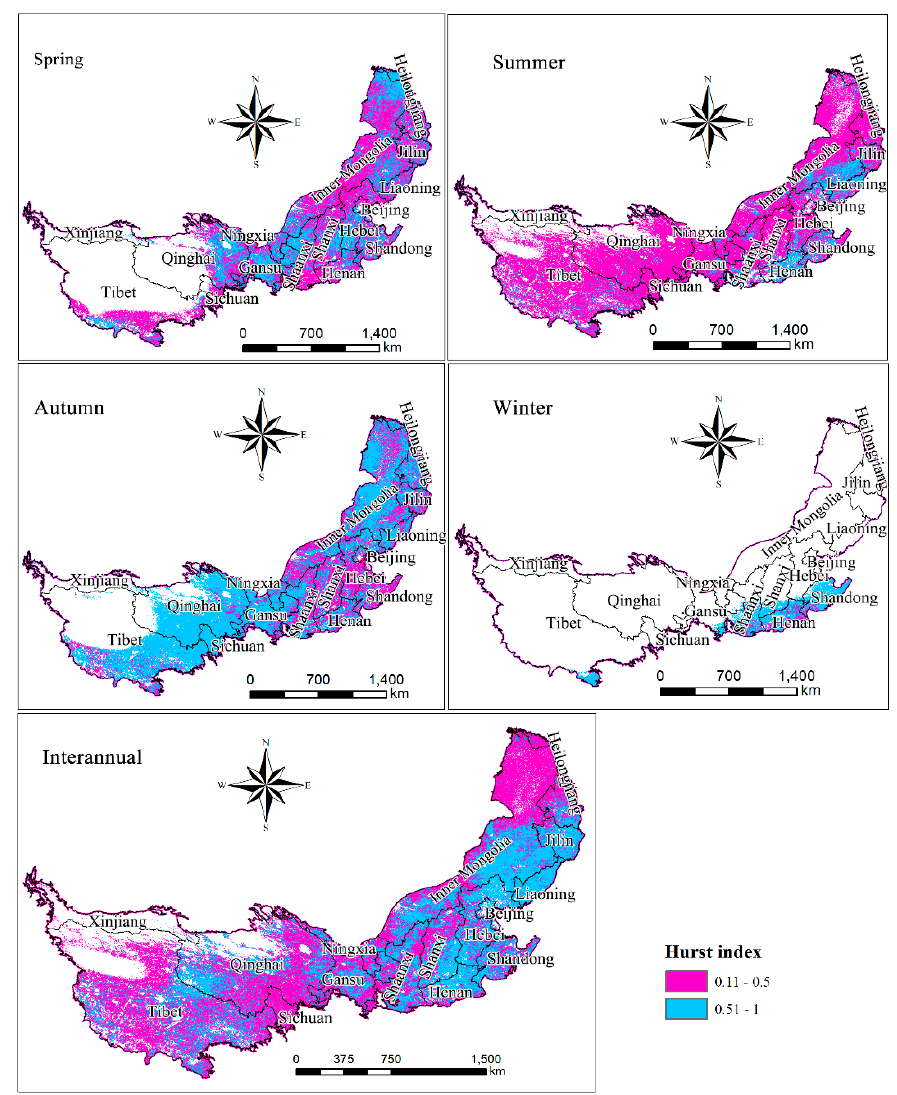
Figure 7. Future trend analysis of net primary productivity in the study area.